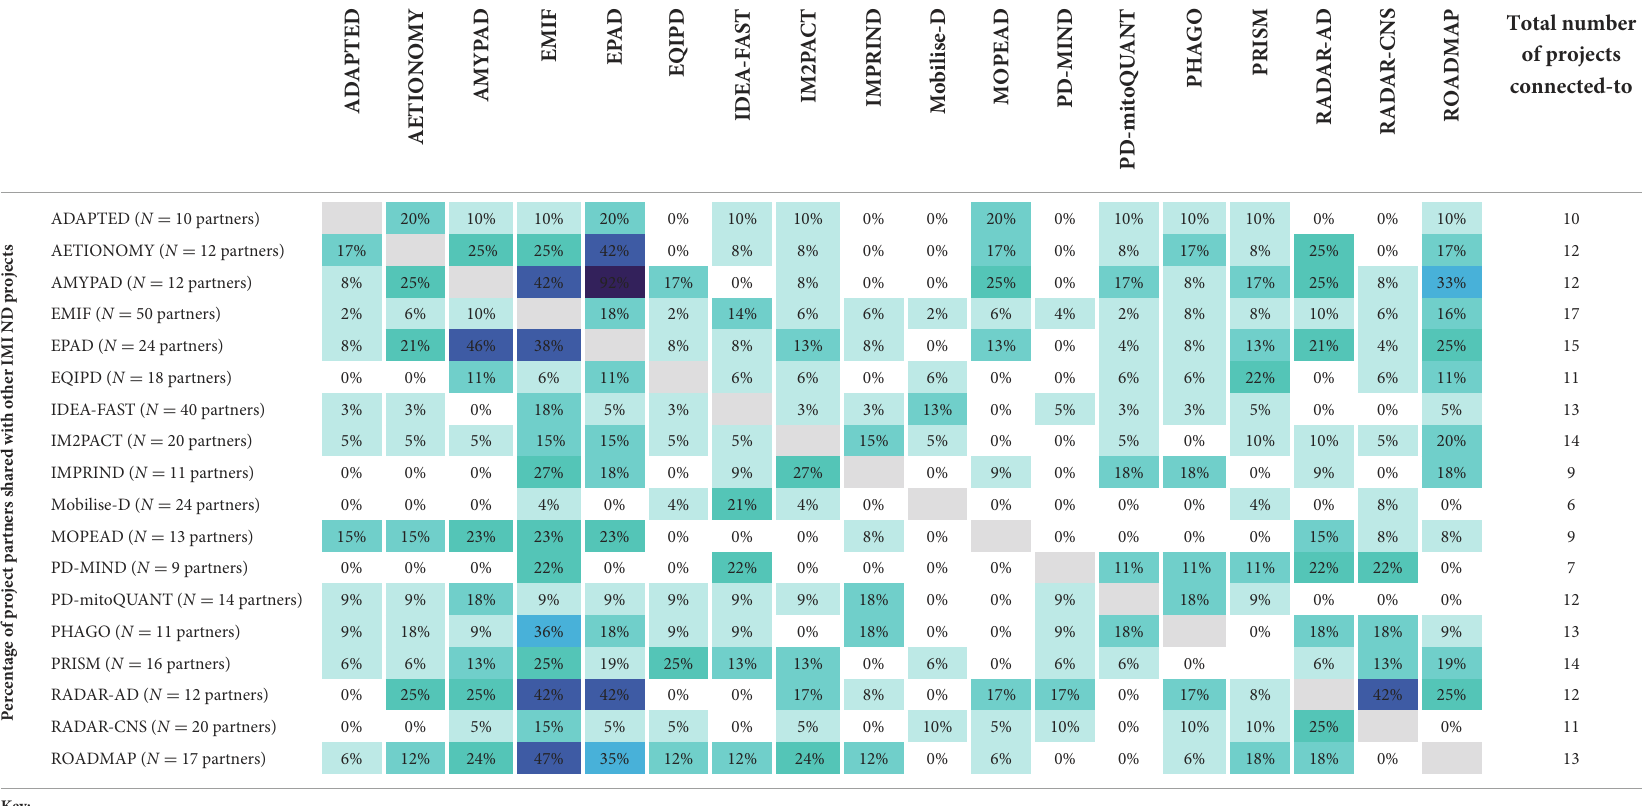
TABLE 4B Percentage of project partners shared between IMI NDD projects (excluding